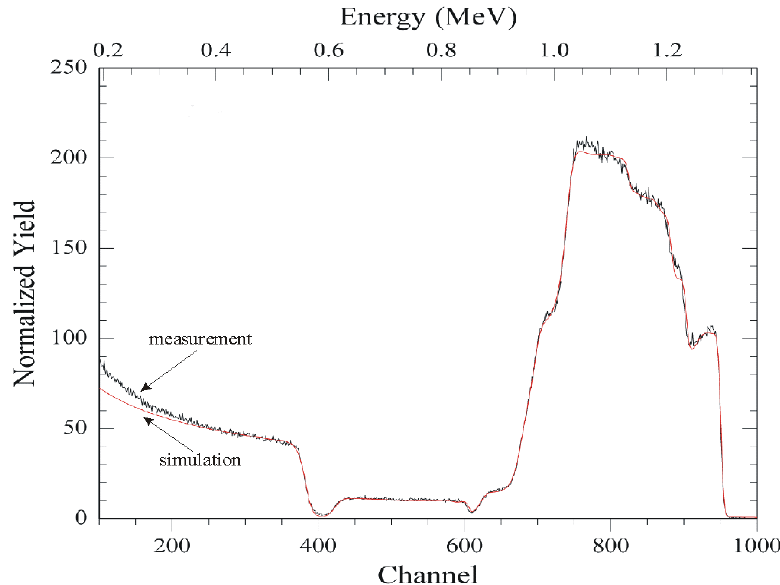
Figure 6 : RBS measurement of chalcogenide glass layer system of Pb-Ag-As-I-S onto a silicon